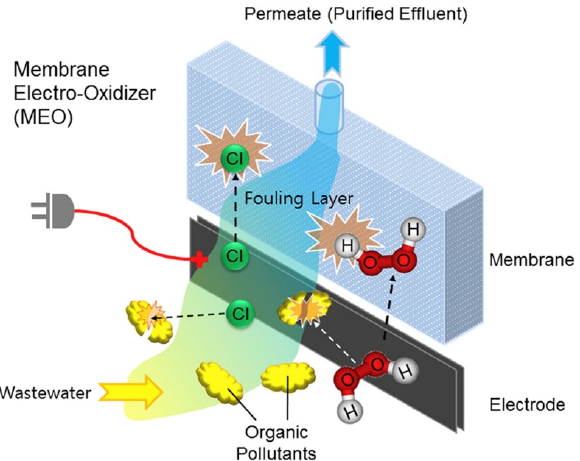
Figure 8. Organic contaminant removal by electrochemical oxidation by electrically responsive membranes. Reproduced with permission from [84] .